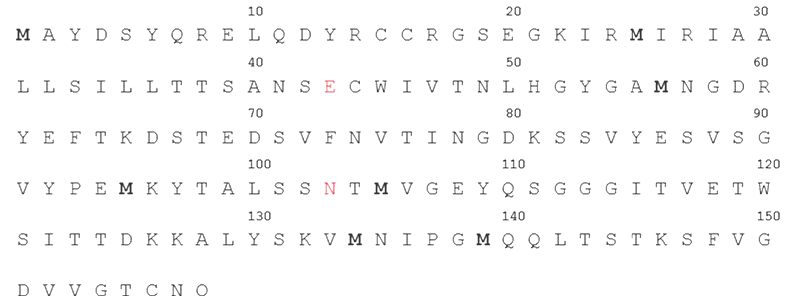
Figure 2. The putative amino acid sequence of Hex. The predicted amino acid sequence starts from the 5'-most AUG, in the hex transcript. Additional potential methionine initiators highlighted. The red amino acids highlight the beginning and end of the sHex polypeptide (see also Figure